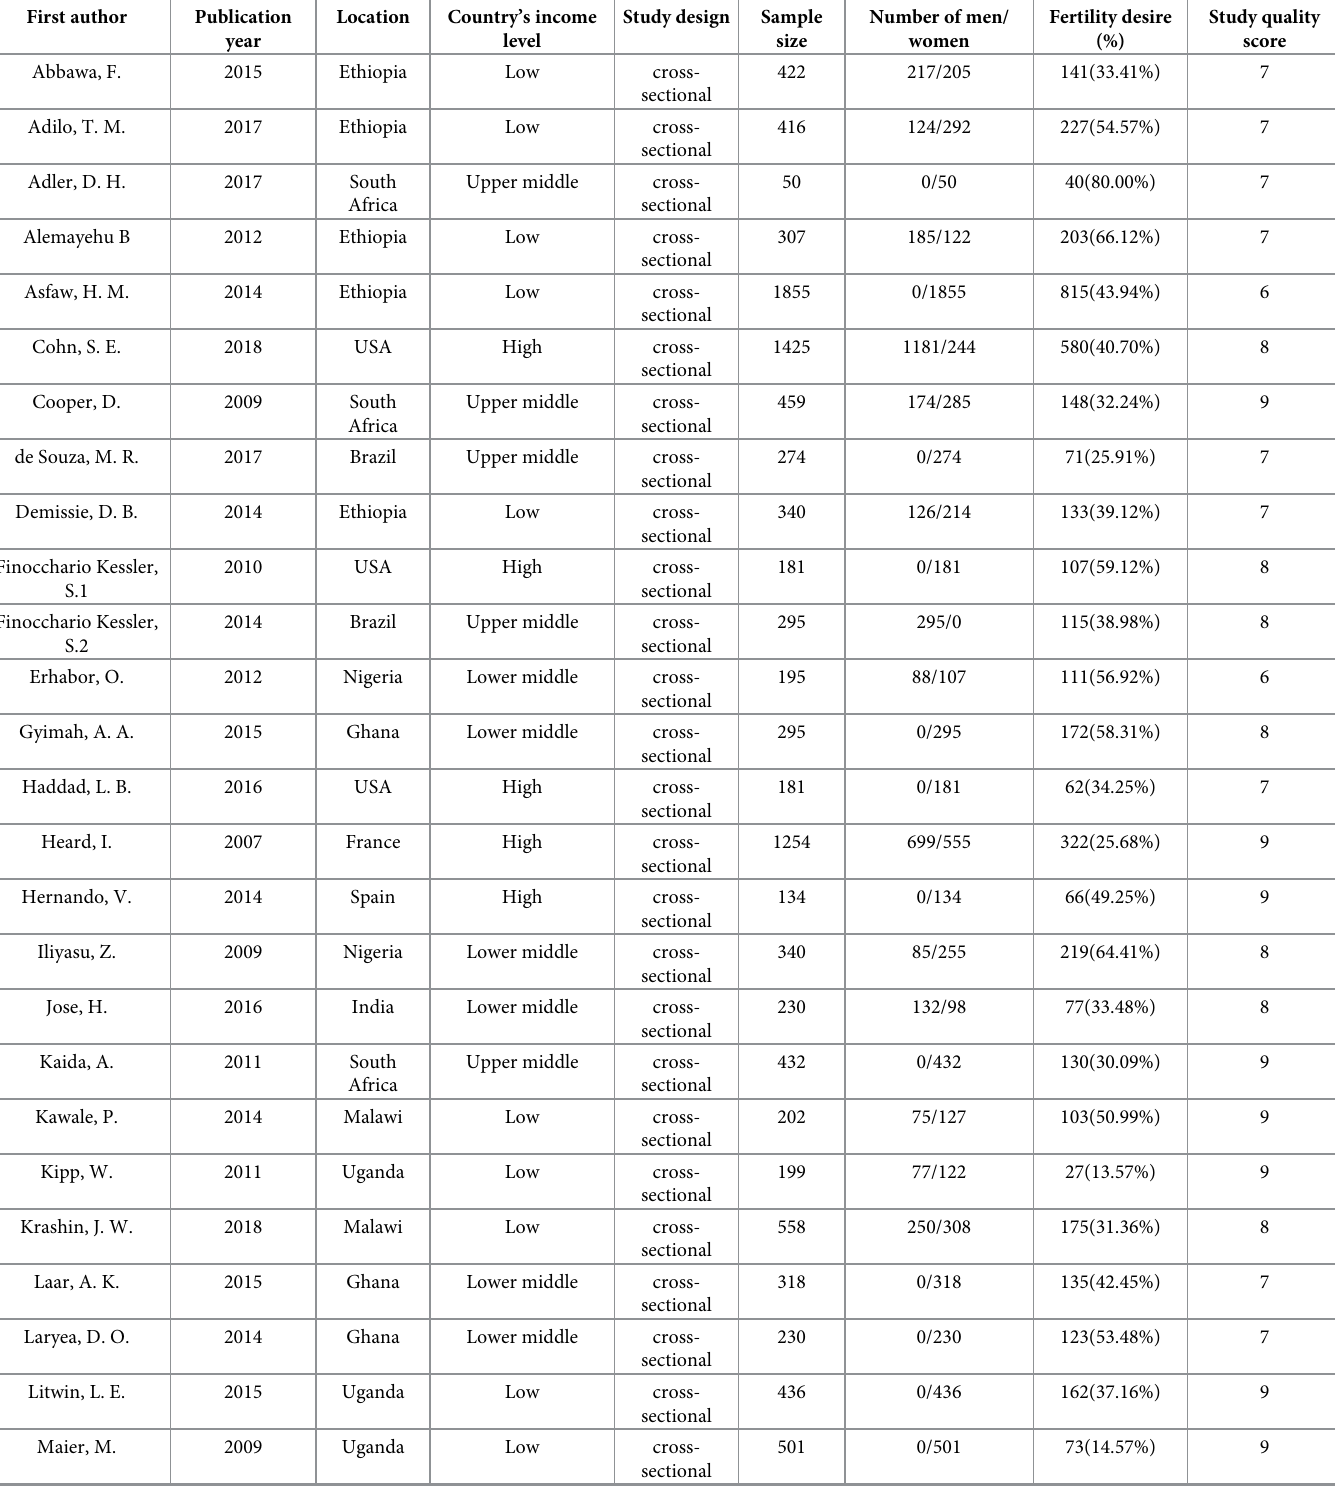
Table 1. The main features of the studies included in the